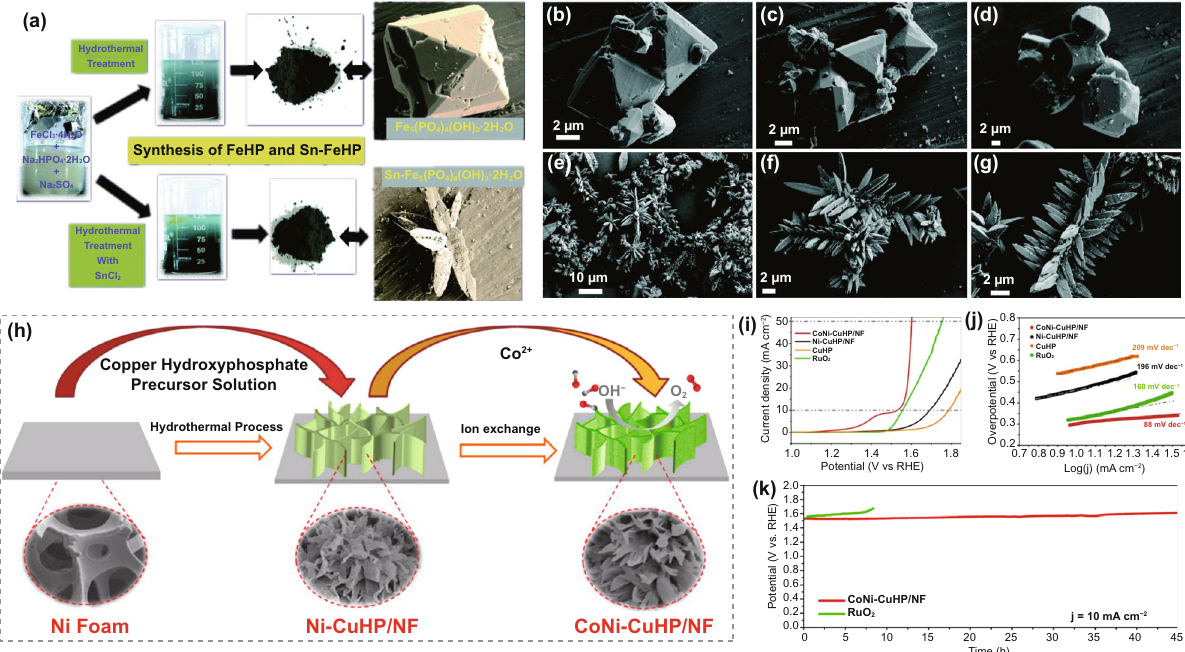
Fig. 8 a The synthesis of FeHP and Sn-FeHP from iron(III) chloride, tin(II) chloride, and disodium hydrogen phosphate. b–d FE-SEM images of FeHP octahedral crystals, e–g FE-SEM images of Sn–FeHP self-assembled needle-like microcrystals. Reprinted with permission from Ref. [126]. Copyright Year 2017, Royal Society of Chemistry. h Schematic illustration of the synthesis of CoNi–CuHP/NF, i LSV curves, and j the related Tafel curves of CoNi–CuHP/NF and different catalysts, k long-term cycling tests of the CoNi–CuHP/NF catalyst and commercial RuO 2 . Reprinted with permission from Ref. [125]. Copyright Year 2017, Royal Society of